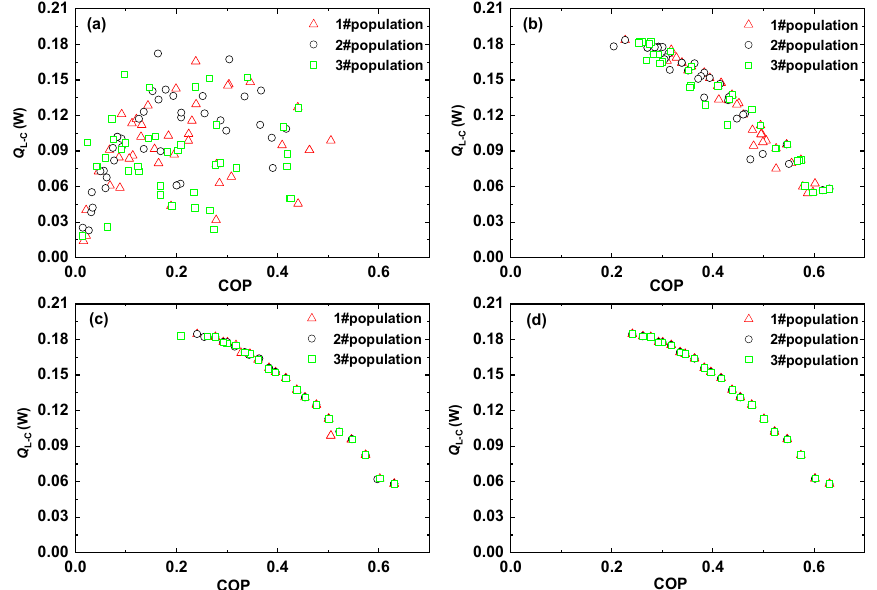
Figure 7. Distribution of Pareto fronts with three different populations: ( a ) the first generation; ( b ) the fourth generation; ( c ) the tenth generation; and ( d ) the eightieth generation.